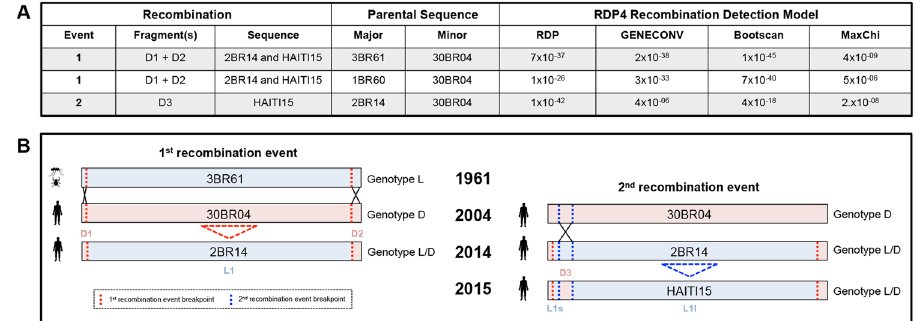
Figure 1. Schematic representation of the identified recombination events associated with MAYV variants 2BR14 and HAITI15. ( A ) Identified recombinant sequences and fragments using various detection models. Significant p-values are indicated (alpha = 0.05), whereas ‘NS’ denotes the absence of statistical support (not significant). First recombination event based on dataset excluding 3BR61 sequence. ( B ) The first recombination event between the minor parental 30BR04 (red) and the major parental 3BR61 (green) gave rise to the recombinant strain 2BR14; the second recombination even between minor parental, 30BR04, and the major parental, the recombinant 2BR14, resulted in the recombinant strain HAITI15. Dotted blue lines indicate genomic breakpoints. The source of isolation of the strains is indicated with the schematic human, mosquito and tick black icons. Schematic representations are based on the results of recombination analysis in